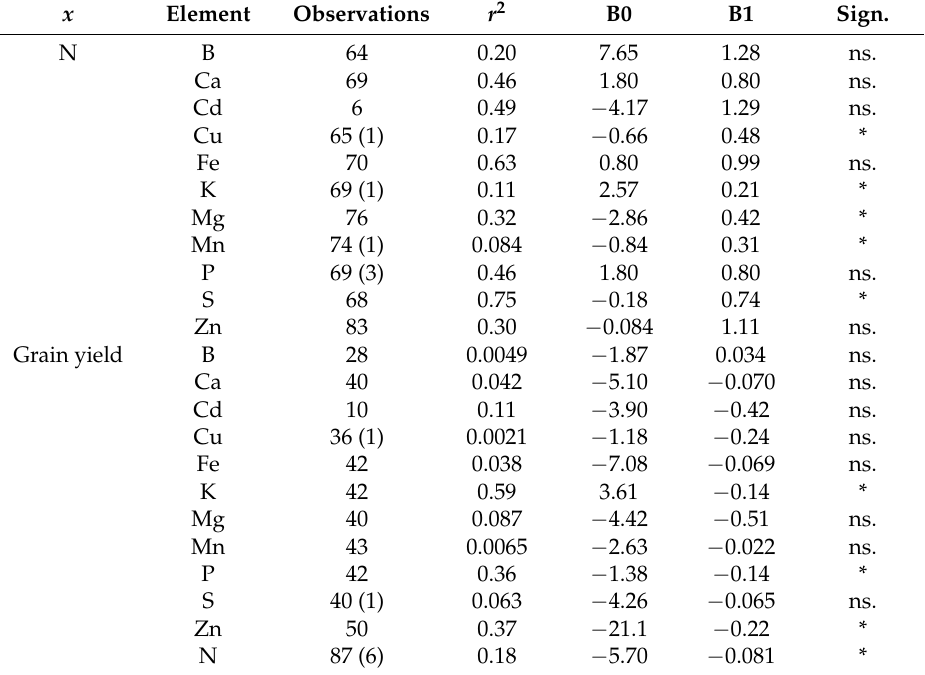
Table 2. Response functions for the linear regression between the relative eCO 2 effect on the concentration of various minerals with the eCO 2 effect on N concentration and grain